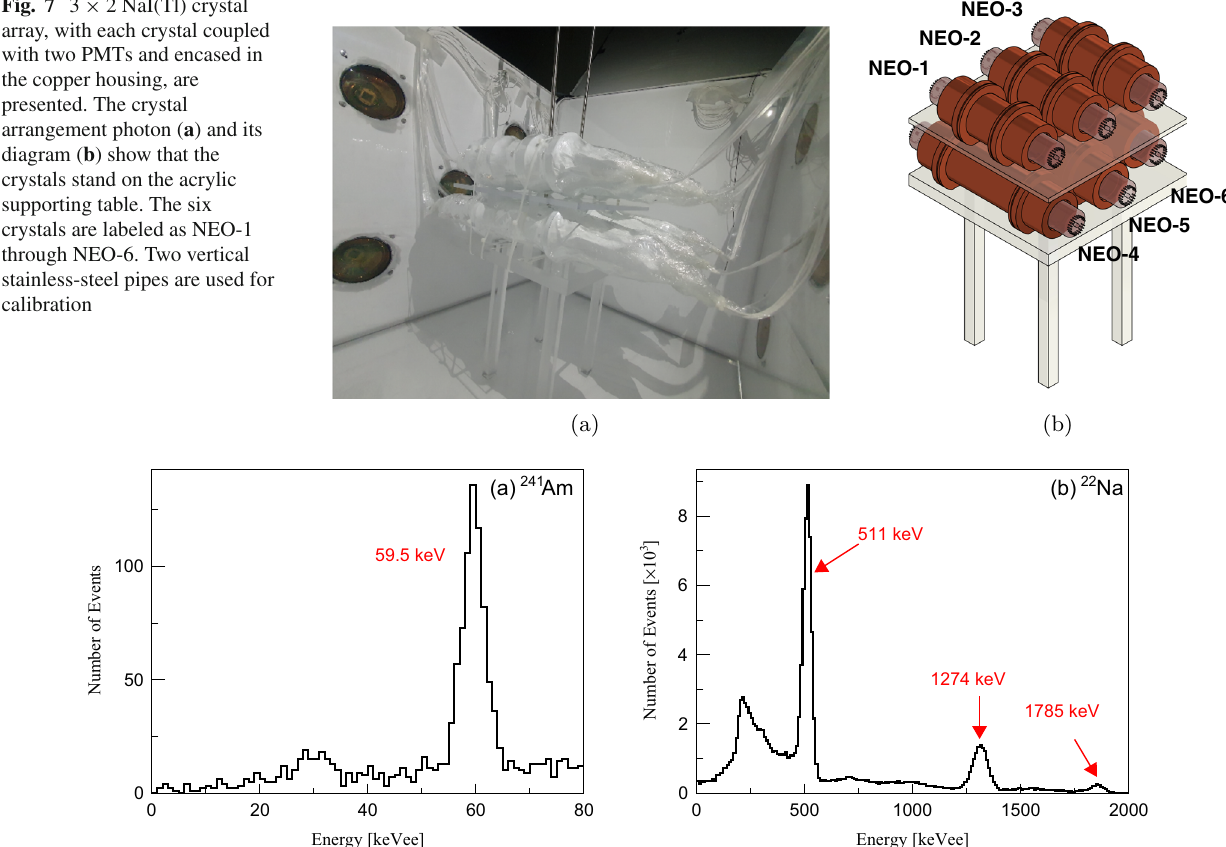
Fig. 8 Energy spectra of 241 Am ( a ) and 22 Na ( b ) calibration data of the NEO-5